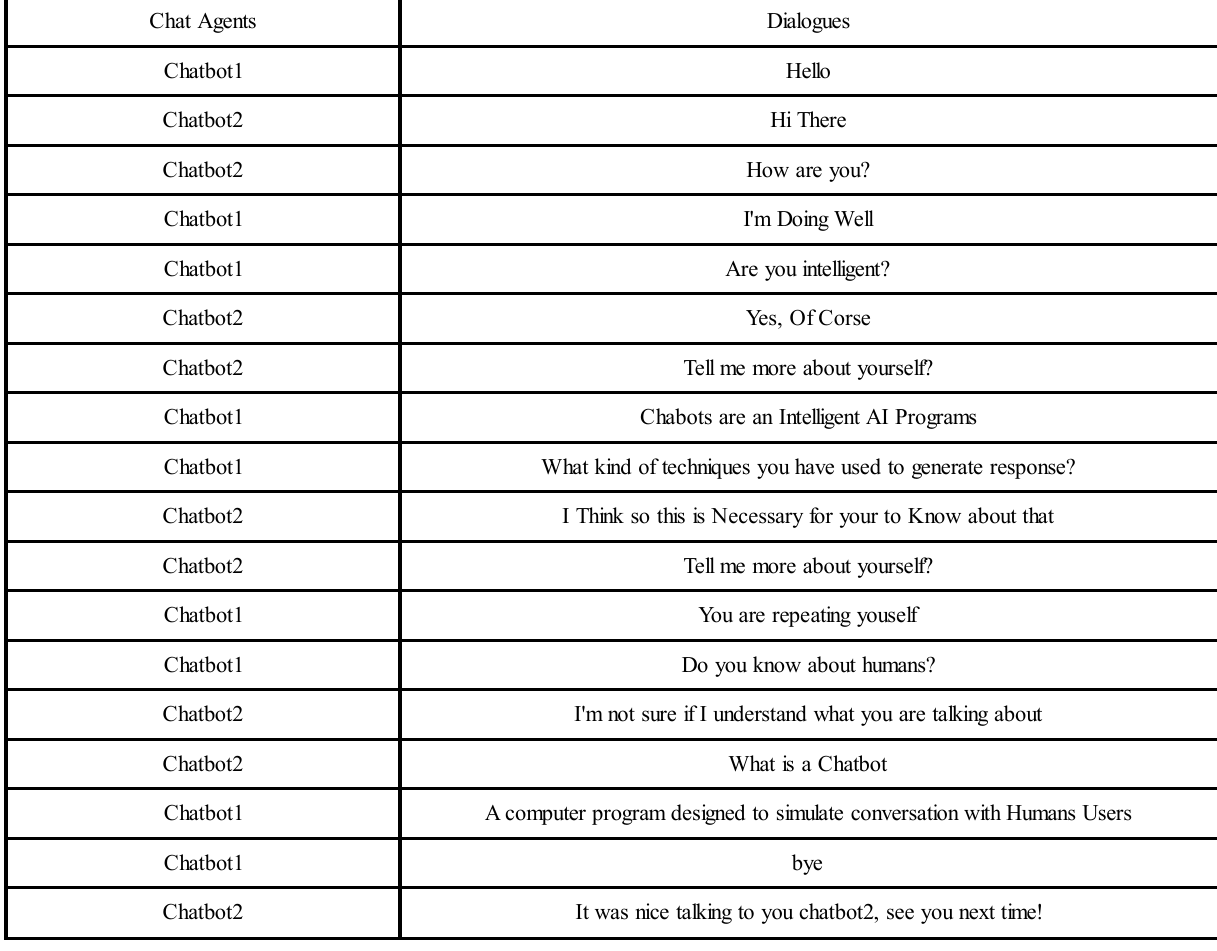
TABLE 1. THE CONVERSATIONAL DIALOGUES BETWEEN TWO